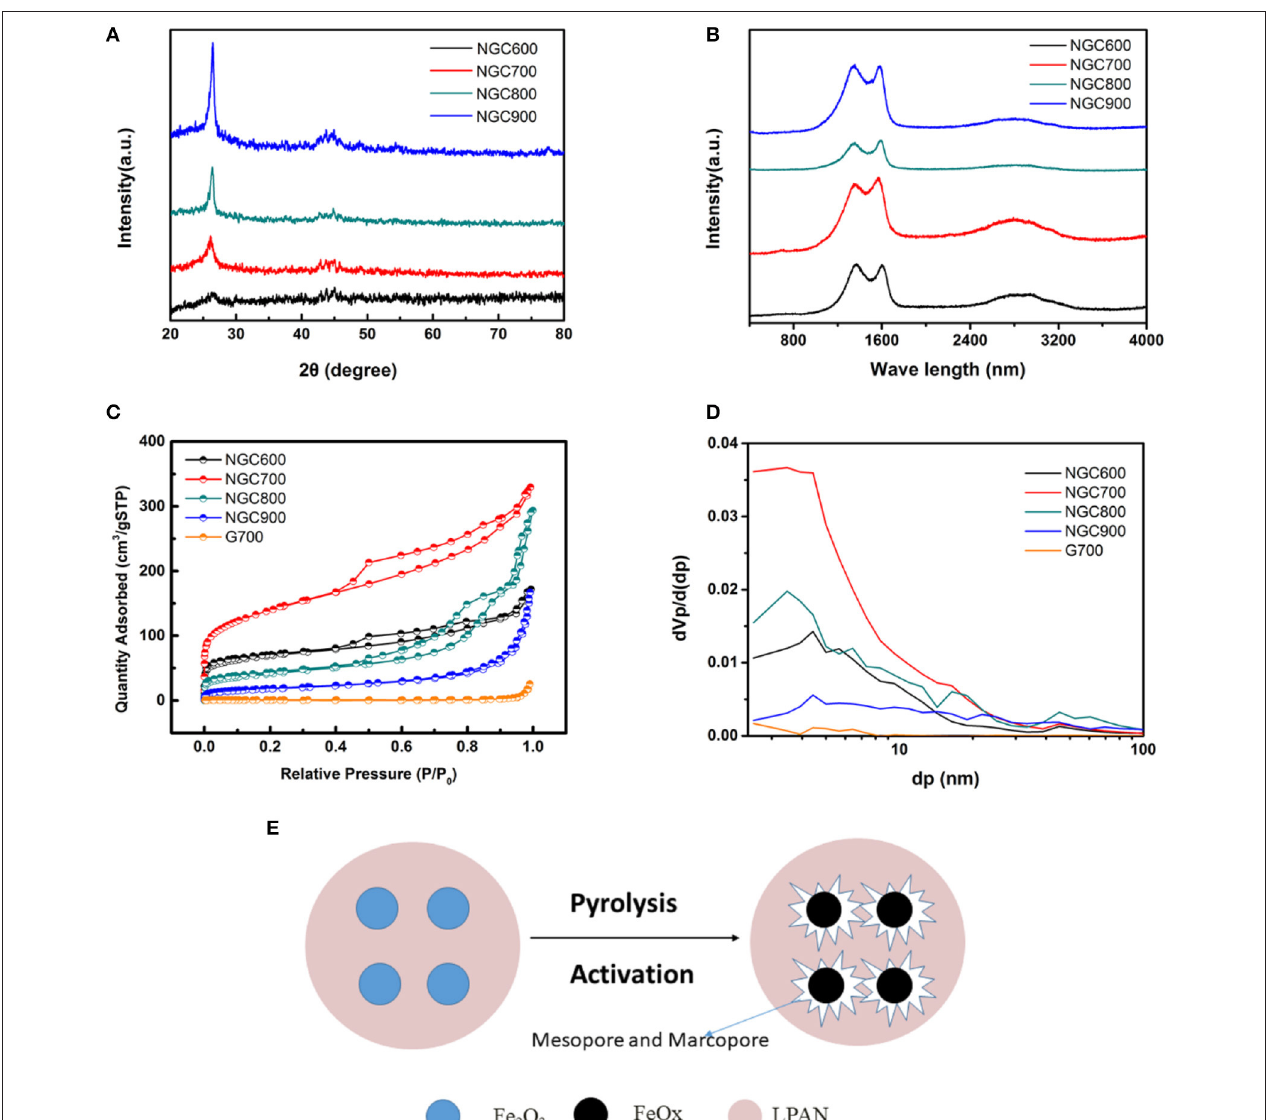
FIGURE 4 | (A) XRD patterns and (B) Raman spectra of NGCs. (C) N 2 adsorption/desorption isothermal and (D) pore size distribution curves of NGC600, NGC700, NGC800, and NGC900. (E) Schematic diagram of the activation of porous carbon by FeO x .